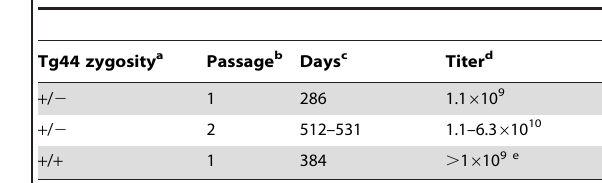
Table 2. Infectivity titers of 22L scrapie from brains of Tg44 mice after 1 or 2